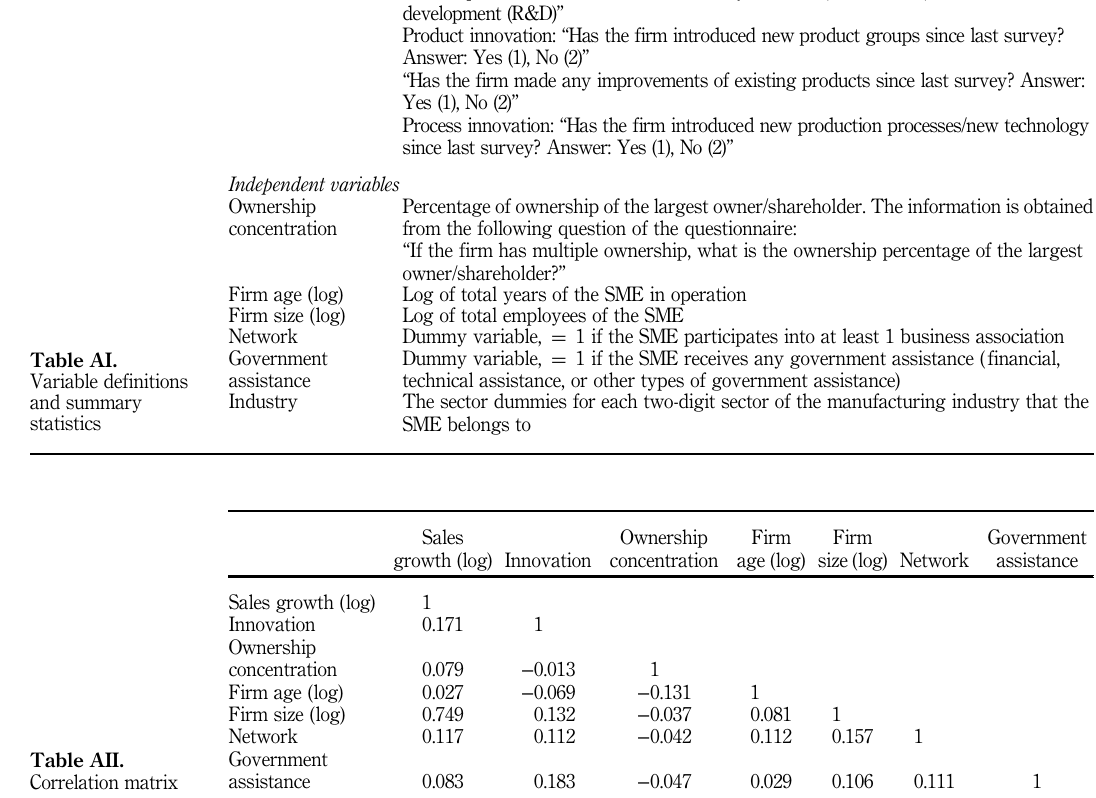
Table AII. Correlation